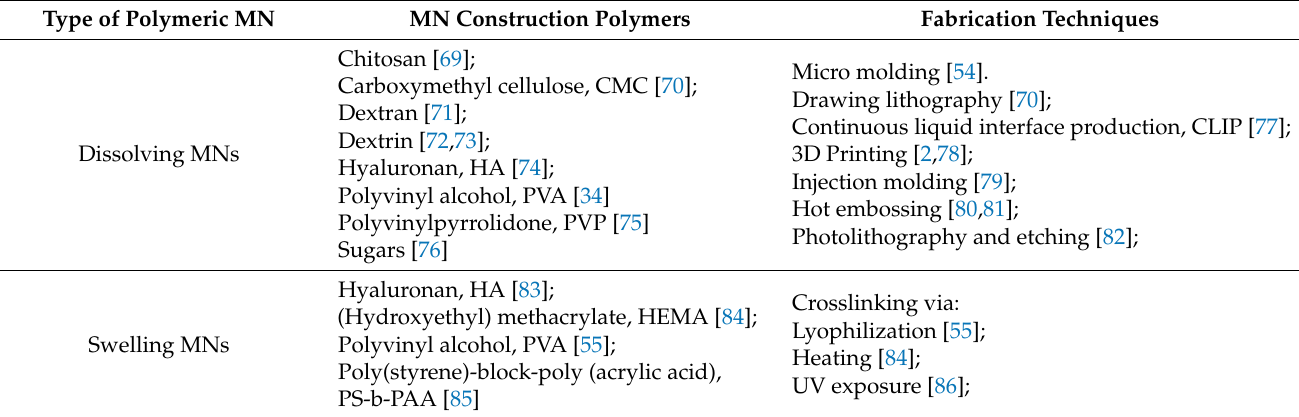
Table 2. Various polymers and fabrication techniques for dissolving and swellable MNs. Type of Polymeric